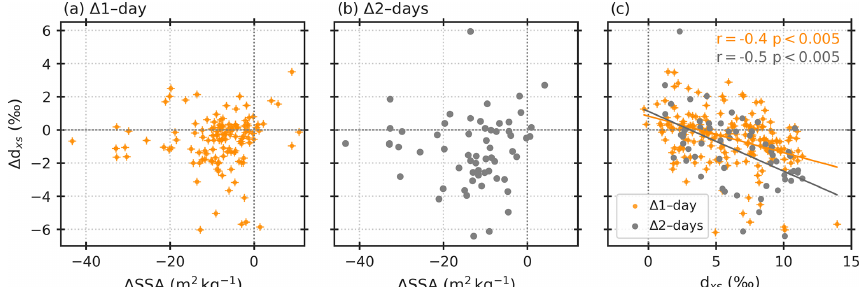
Figure 5. Isotopic changes during all of the analysed events are shown, with each point indicating a specific sampling site. The daily change in d-excess ( d xs ) and SSA is presented in (a) , change in d-excess and SSA over the first 2d of each event is shown in (b) , and the respective changes in d-excess are plotted against the absolute d-excess values in (c) . Linear regressions are included for daily change (orange) and 2d change (grey). Table 3. Table of isotopic change for decay events. Mean values on Day-0 and Day-2 of each event, and percentage change over this 2d period are presented for δ 18 O, d-excess and SSA. Low-wind events (bold text) and moderate-wind events are presented. δ 18 O d-excess